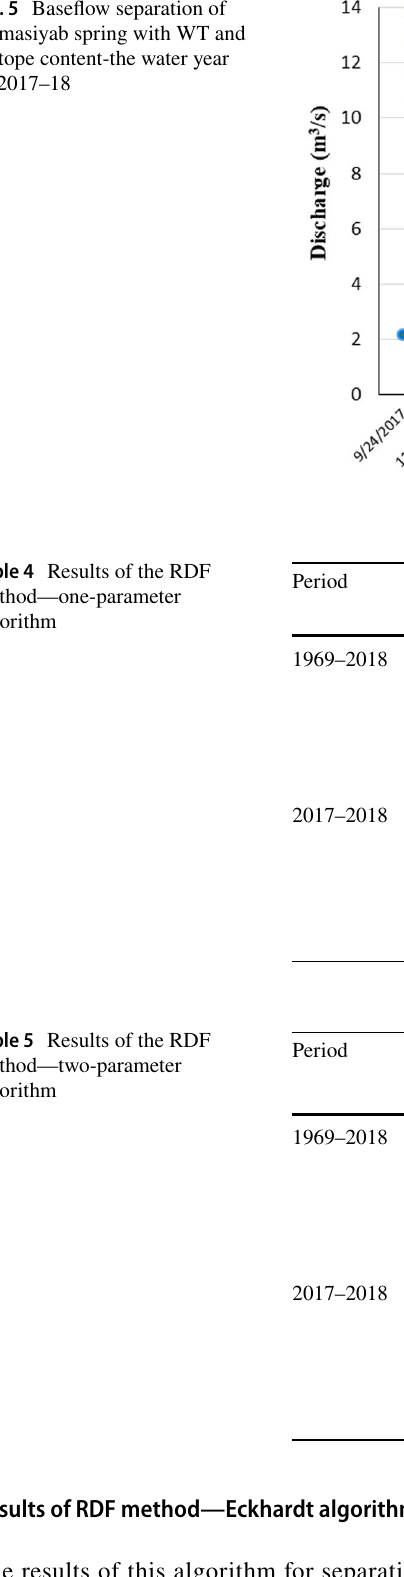
Fig. 5 Baseflow separation